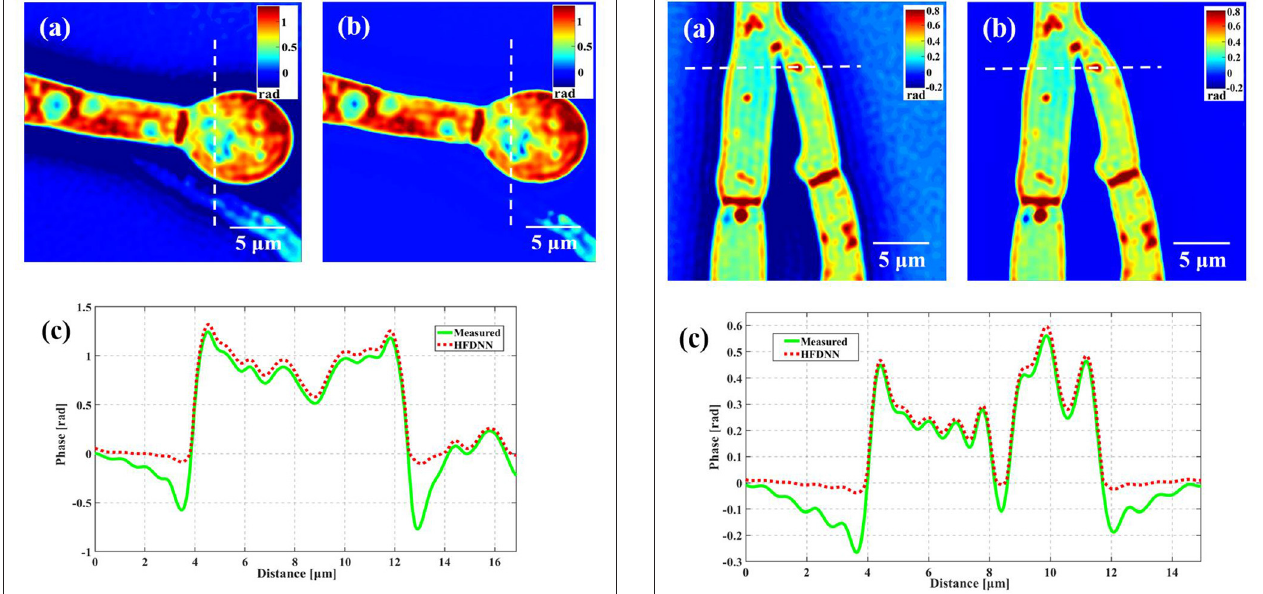
FIGURE 8 | The reconstructed results of the hyphae branches in monascus. (a) The measured image; (b) the reconstructed image by the HFDNN without re-training; (c) the phase profiles along the same position drawn in (a,b) ; the green curve illustrates the profile of the measured data; the red dash curve illustrates the profile of the